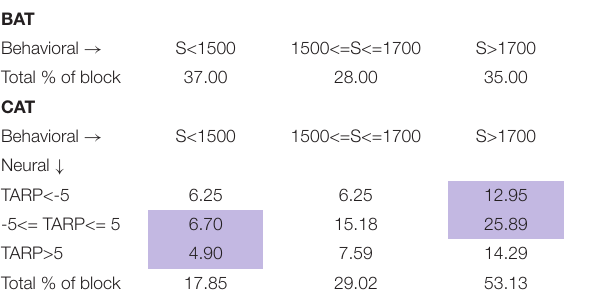
TABLE 2 | Percentage of block scores in adaptive logic